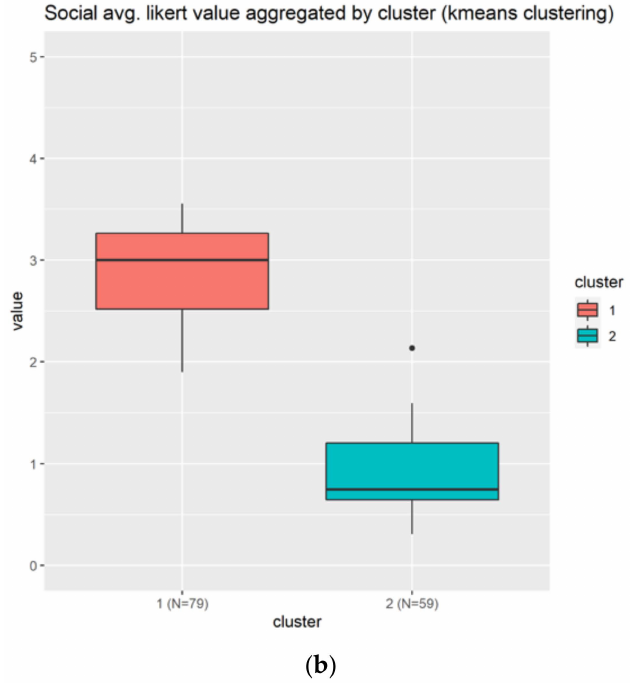
Figure 8. Results for the social related questions. There are two clusters in red and blue. A total of nine questions in subplot ( a ) and two boxplots generated in subplot ( b